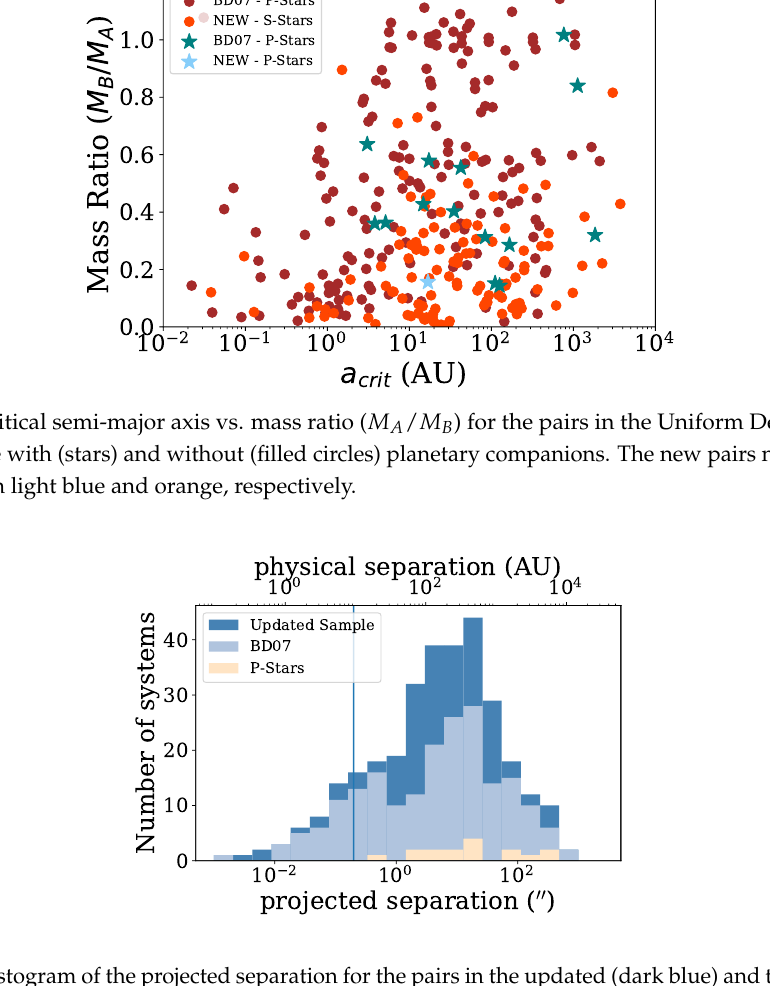
Figure 3. Histogram of the projected separation for the pairs in the updated (dark blue) and the original (light blue) UD binary sample. The number of stars with planets (P-Stars) in the final sample is shown in light orange. The solid line corresponds to ρ = 2 (cid:48)(cid:48)